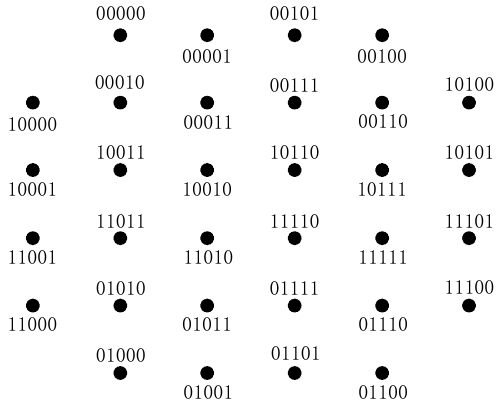
（ b ） Figure 5. Designed labeling scheme with delayed pattern D 4 .